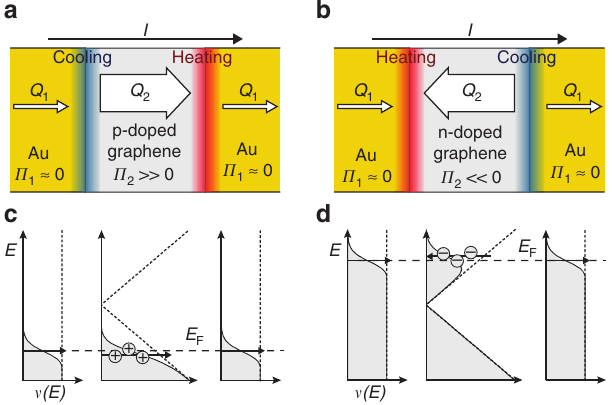
Figure 1 | Depiction of the Peltier effect at a graphene–Au interface. ( a , b ) Graphene (grey) has a larger Peltier coefficient P than Au (yellow) and thus a current I can carry more heat in graphene ( Q 2 ) than in Au ( Q 1 ). As charge flow is conserved, heat is accumulated (red) or absorbed (blue) at the interfaces. ( c , d ) The large P in graphene is caused by the strong variation of the density of states n ( E ) around the Fermi energy E F , lowering or elevating the average energy of the thermalized carriers (indicated by the black arrows). The effect reverses when tuning the carriers from ( a , c ) the hole regime to ( b , d ) the electron